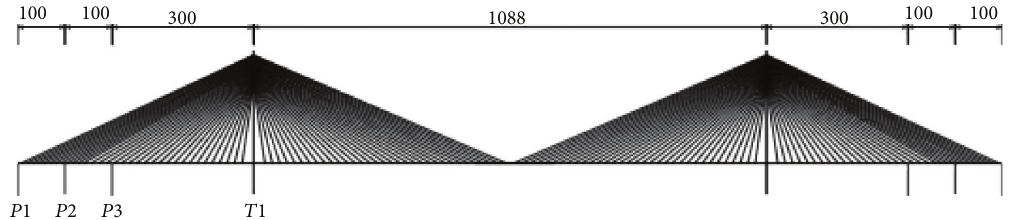
Figure 1: Elevation of the highway